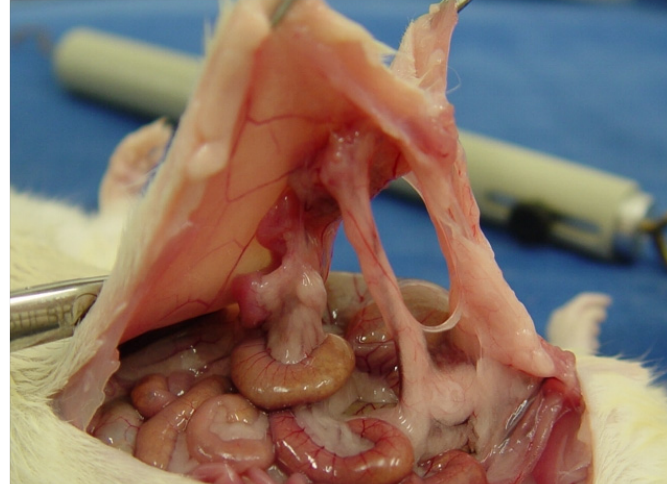
FIGURE 1 - Rat from group 1 with adhesions to the polypropylene